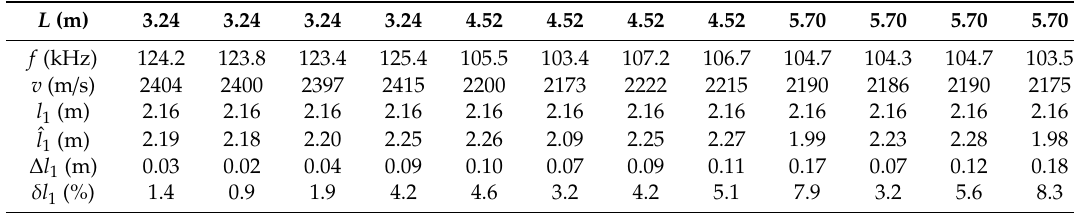
Table 3. The location results obtained by the MLPNN